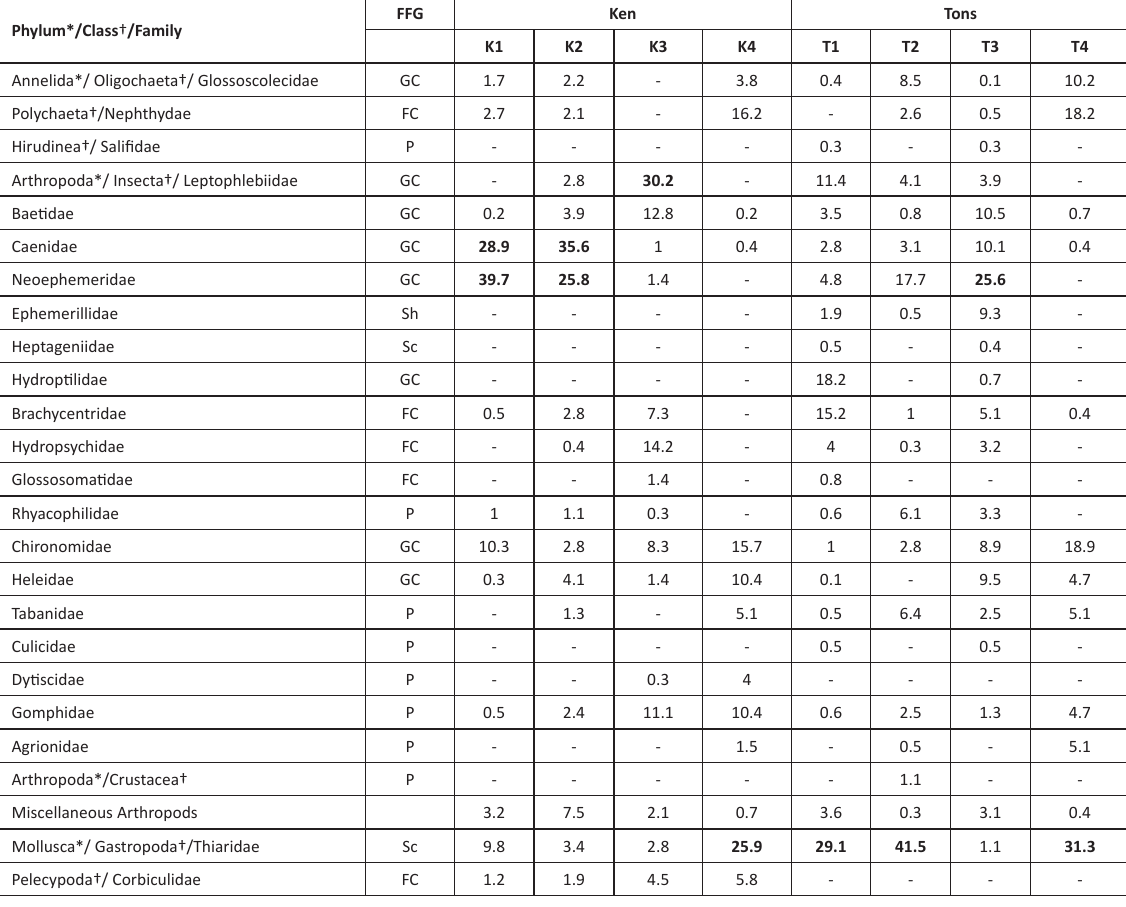
Table 3. Relative abundance of the taxa along with their functional feeding groups at different stations in the river Ken and Tons. FFG Phylum*/Class † /Family